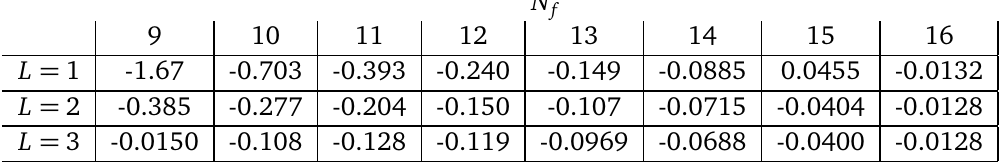
for the QCD-like model at L loops obtained in- +